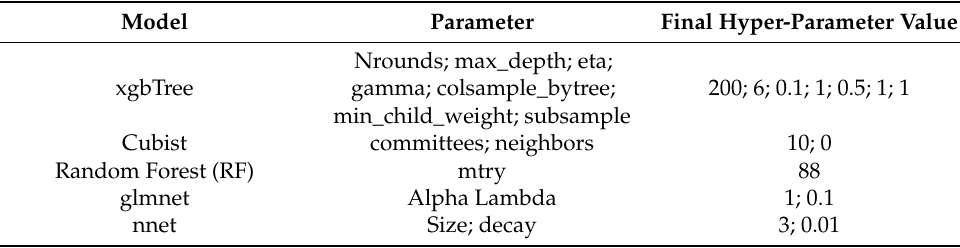
Table 2. Hyperparameters tested and final values for the models used. Model Parameter Final Hyper-Parameter Value